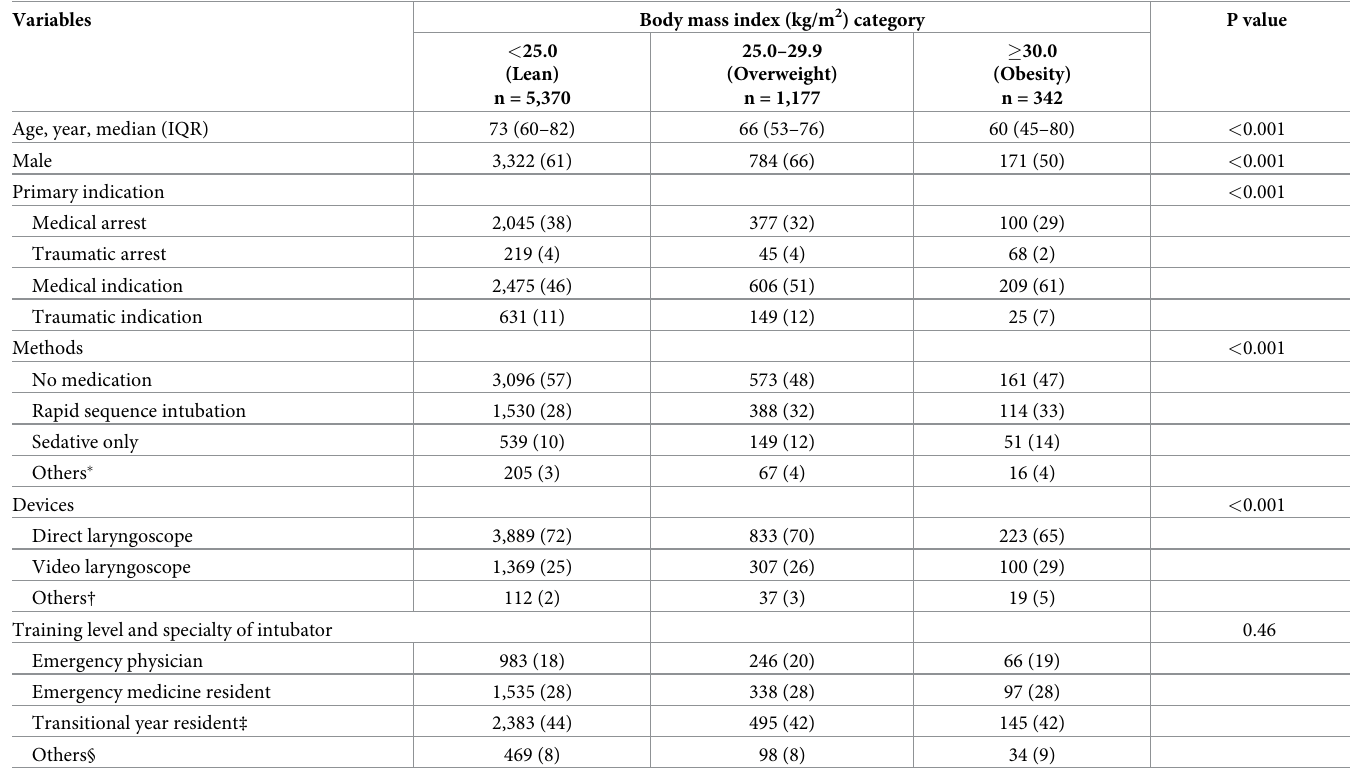
Table 1. Baseline characteristics of 6,889 patients who underwent tracheal intubation in the emergency department, according to body mass index category.